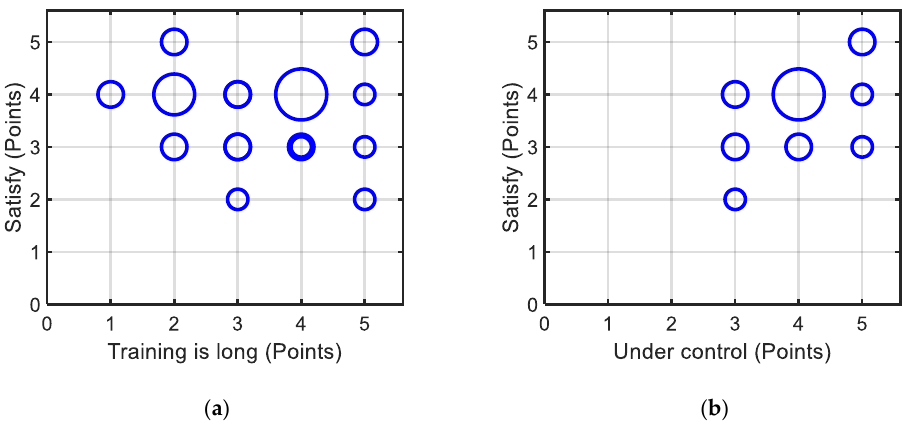
Figure 17. Results of the questionnaire. The larger the circle, the greater the number of users in that situation: ( a ) relationship between training duration and overall satisfaction, and ( b ) relationship between the feeling of under control and overall satisfaction.